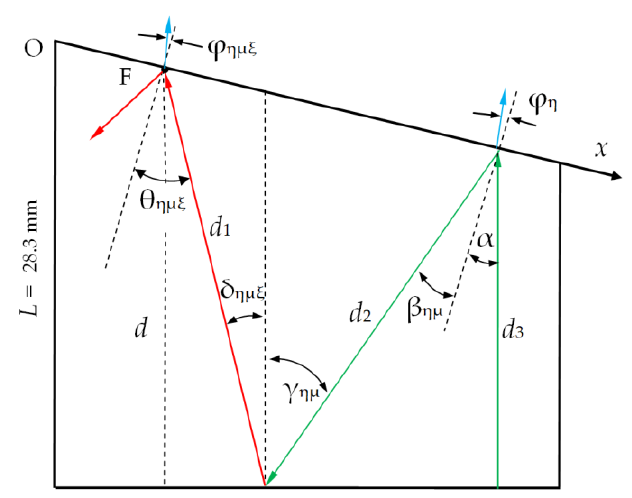
Figure 2. Ray model of the acoustic wave propagation in the AO cell.